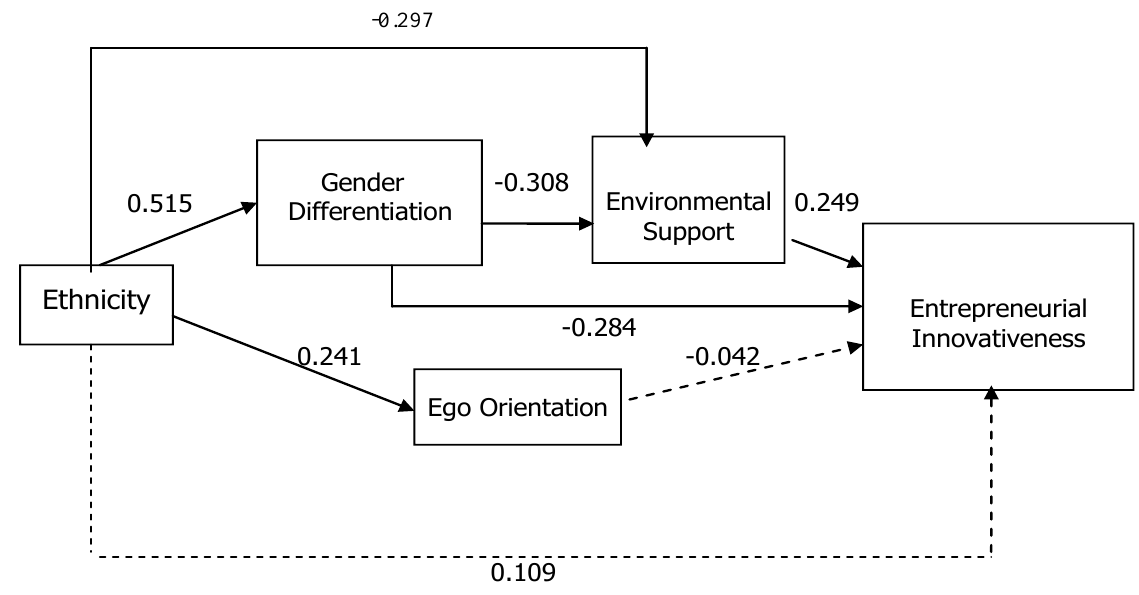
Figure 1: Multiple regressions on the full-effects model